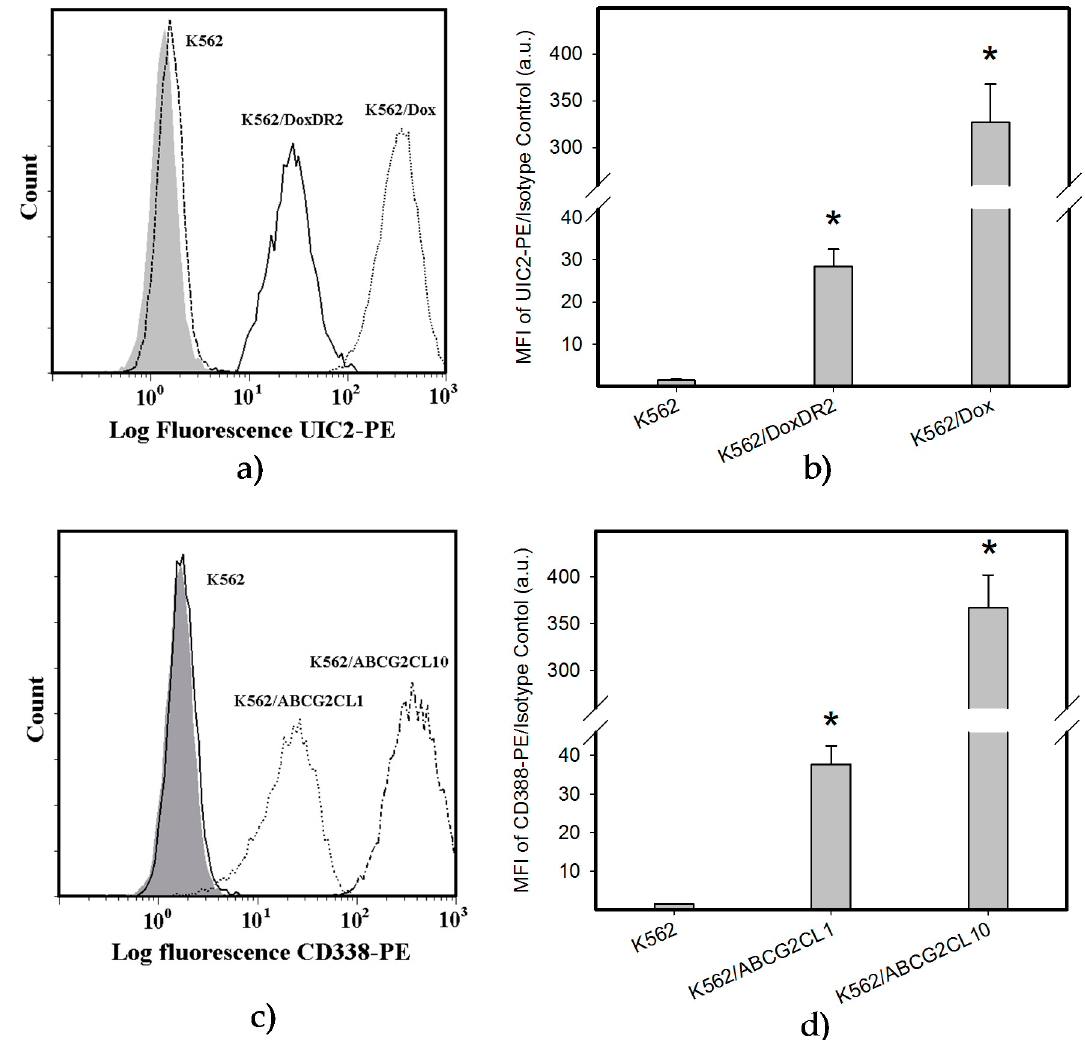
Figure 8. Analysis of ABCB1 and ABCG2 expression: ( a ) Flow cytometric analysis of ABCB1 expression. Isotype control (grey histogram); K562 parental cell line (dash line); K562/Dox cells (dot line); K562/DoxDR2 cells (solid line). ( b ) Quantitative analysis of ABCB1 expression. ABCB1 expression was quantified as the mean fluorescence intensity (MFI) shift (ratio of MFI of UIC2-PE antibody and isotype control). The experimental points represent mean values from three replicate experiments, with standard deviations; * denotes significant change in ABCB1 expression ( p < 0.05) between K562 cells and cells expressing various levels of ABCB1 (K562/Dox, K562/DoxDR2). ( c ) Flow cytometric analysis of ABCG2 expression. Isotype control (grey histogram); K562 parental cell line (solid line); K562/ABCG2CL10 cells (dash-dot line); K562/ABCGCL1 cells (dot line). ( d ) Quantitative analysis of ABCG2 expression. ABCG2 expression was quantified as the mean fluorescence intensity (MFI) shift (ratio of MFI of CD338-PE antibody and isotype control). The experimental points represent mean values from three replicate experiments, with standard deviations; * denotes significant change in ABCG2 expression ( p < 0.05) between K562 cells and cells expressing various levels of ABCG2 (K562/ABCGCL10, K562/ABCGCL1).